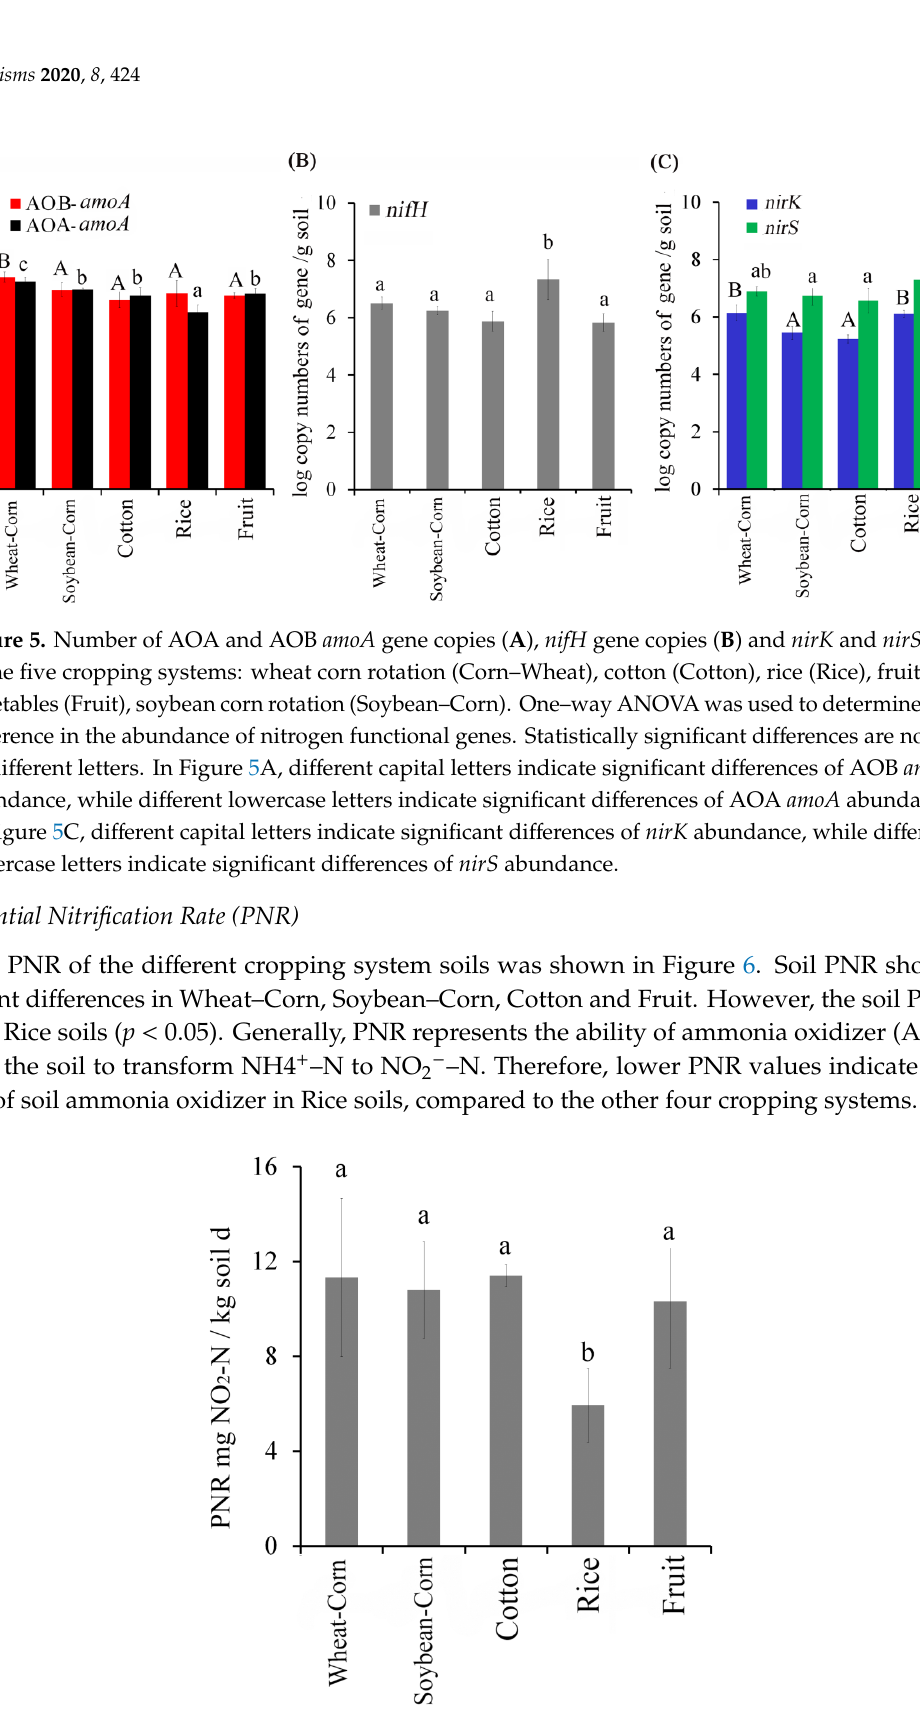
Figure 6. Soil PNR in the five cropping systems: wheat corn rotation (Corn–Wheat), cotton (Cotton), used to determine di ff erences in soil PNR across the di ff erent cropping systems. Statistically significant di ff erences are denoted by di ff erent